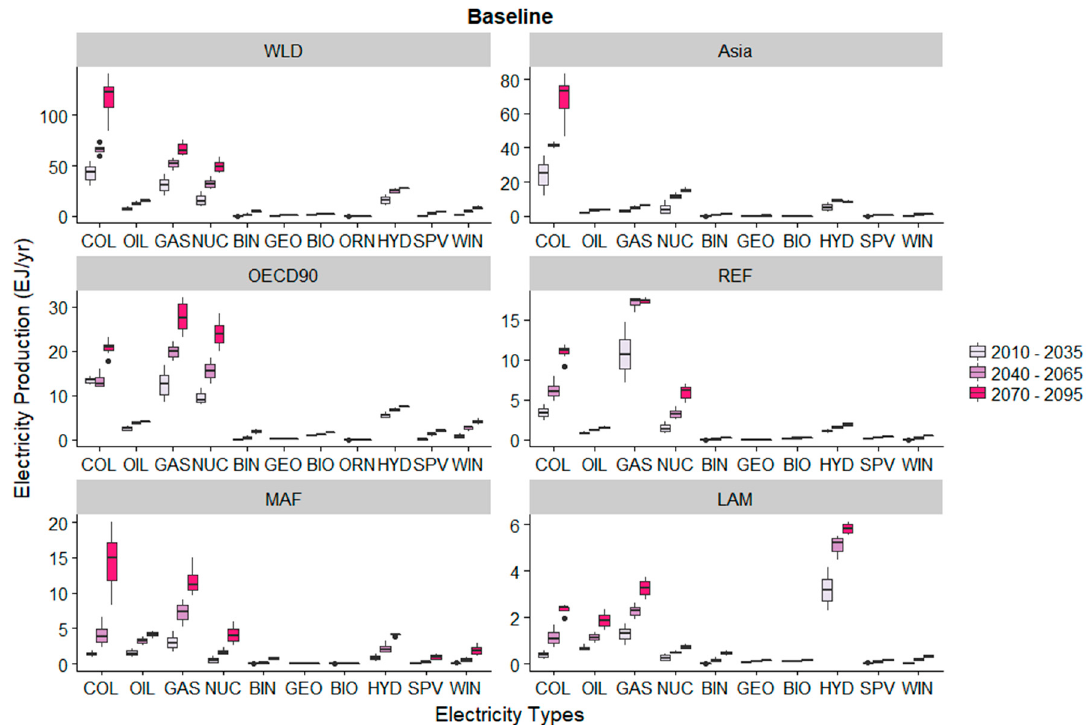
Figure 3. Projections of thermal and non-thermal electricity production in three periods, 2010–2035, 2040–2065, and 2070–2095, for the no climate change impacts (NoCC) run for the entire world (WLD) and for five regions (Asia, OECD90, REF, MAF and LAM; see Table S1). The box plots show the range within each period. The left and right of the dashed line are the thermoelectric and non-thermoelectric sectors, respectively.